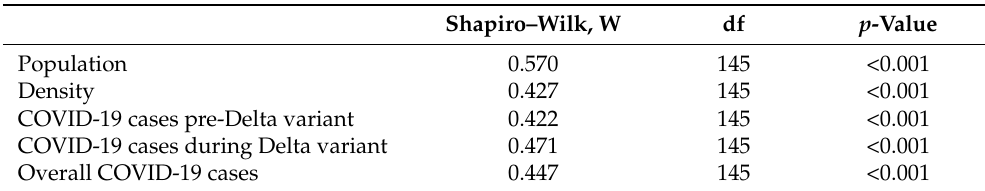
Table A1. Results of Shapiro–Wilk Test for normality of population, density and COVID-19 cases